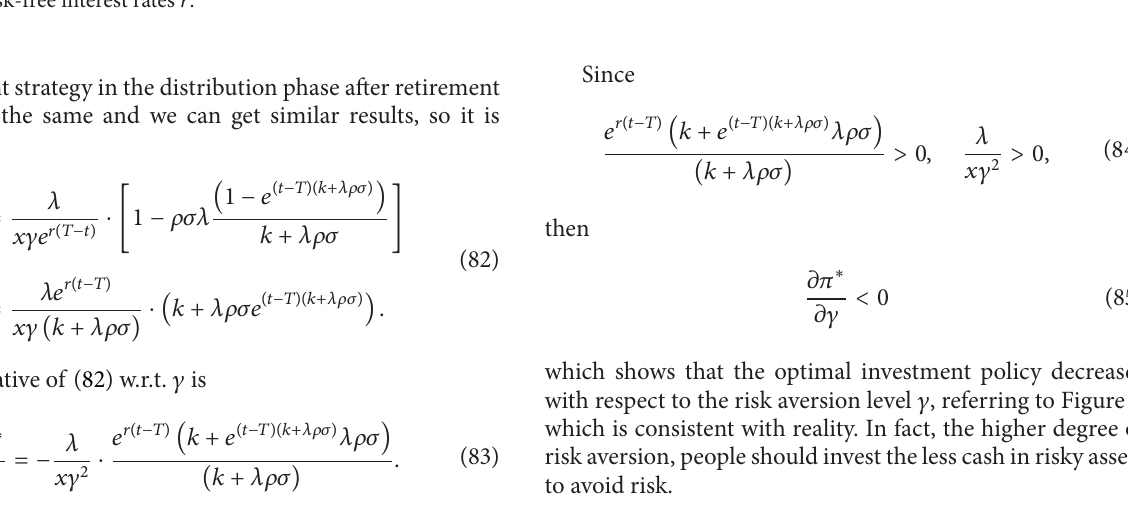
Figure 2: Evolutions of optimal investment strategy 𝜋 ∗ with different risk-free interest rates 𝑟 .